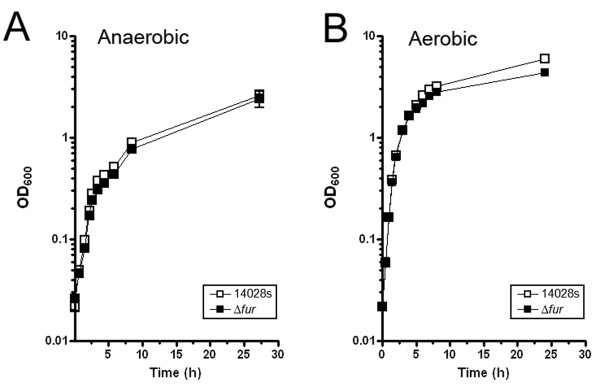
Growth kinetics of Δfur (black square compared to 14028s (white square). Cells were grown in LB-MOPS-X medium as described in Methods; (A) Anaerobic growth; (B) Aerobic growth.